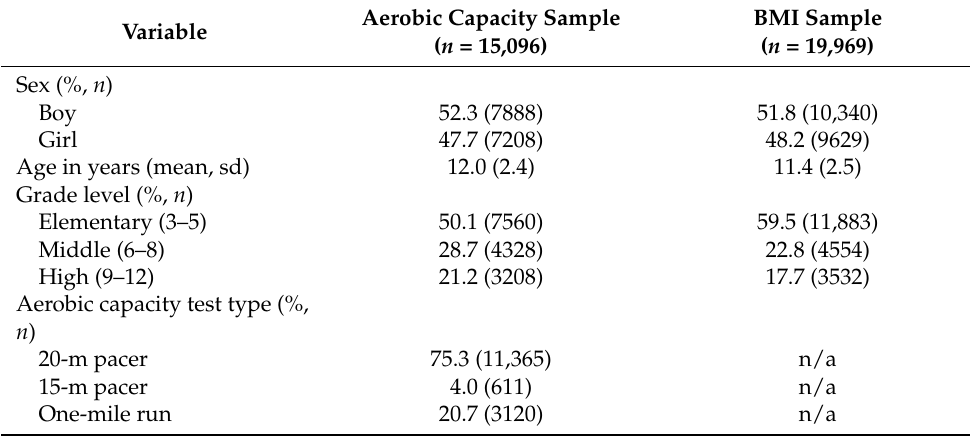
Table 3. Descriptive Information for Students by Outcome Variable.